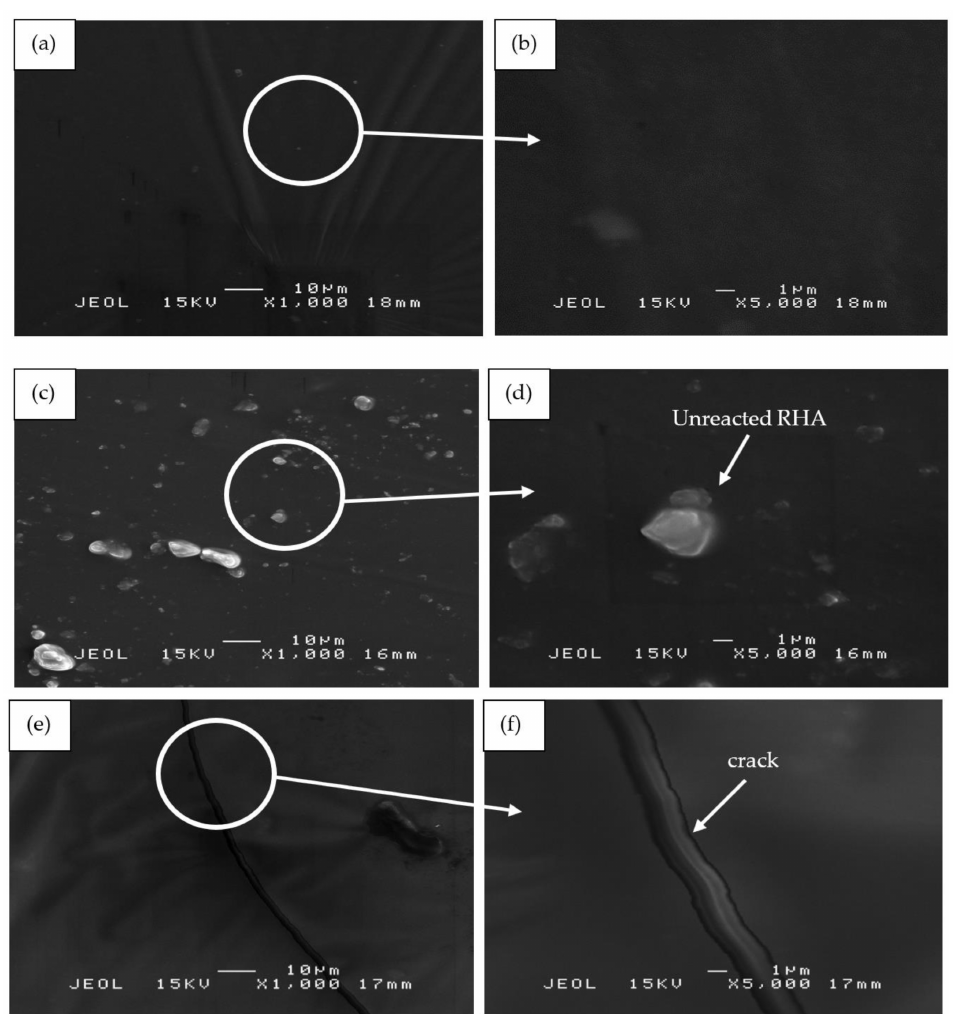
Figure 11. SEM micrographs of RHA/SiR-based binary blended geopolymer coating composite before the fire retardant test with ( a , b ) good (sample S17), ( c , d ) moderate (sample S18), and ( e , f ) poor fire retardant properties (sample S21) at 1000 × and 5000 ×